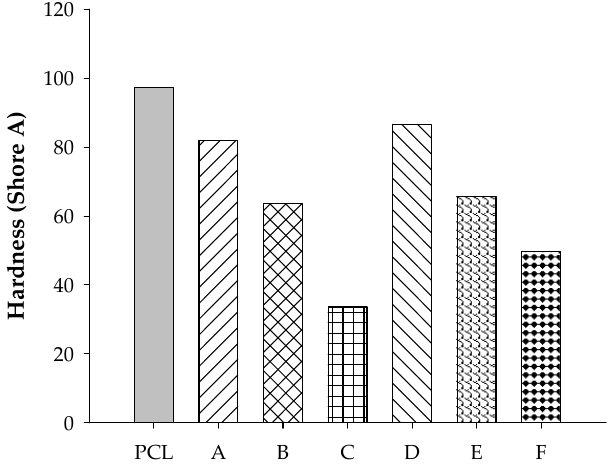
Figure 4. Compression set of PCL, A = STR5L/PCL at 40/60, B = STR5L/PCL at 50/50, C = STR5L/PCL at 60/40, D = ENR-50/PCL at 40/60, E = ENR-50/PCL at 50/50, and F = ENR-50/PCL at 60/40.